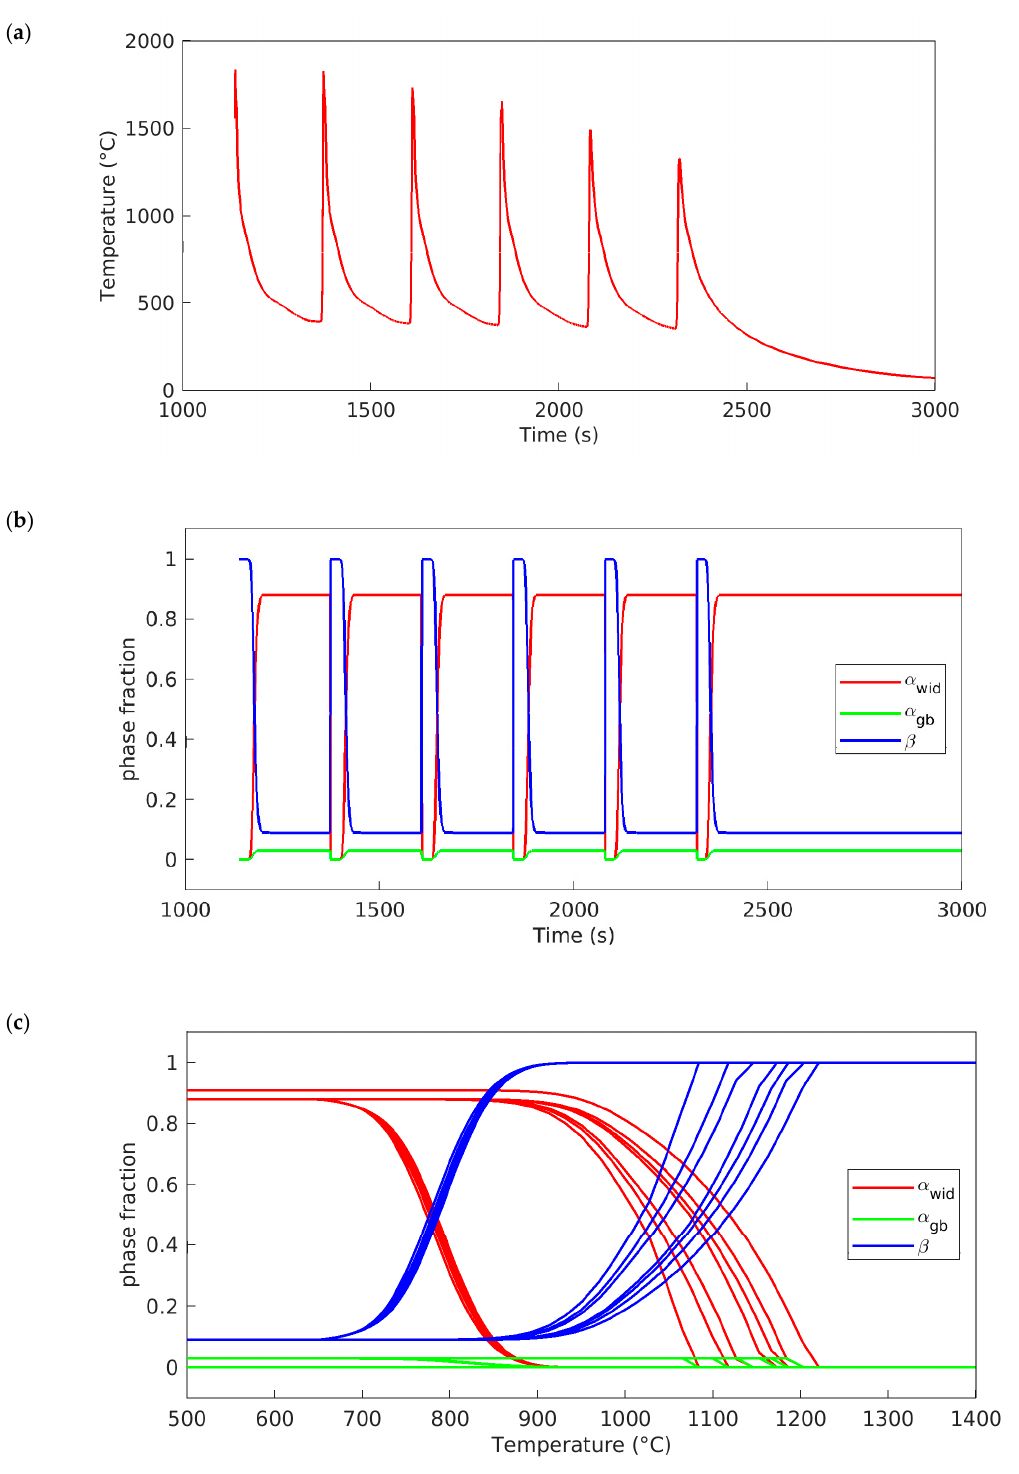
Figure 7. Simulation results at a node positioned in one weld bead cross-section positioned in the B area (Figure 5). ( a ) Temperature variations vs time. ( b ) Corresponding simulated α gb , α wid , and β phase fractions vs time. ( c ) Corresponding simulated α gb , α wid , and β phase fractions vs. temperature.